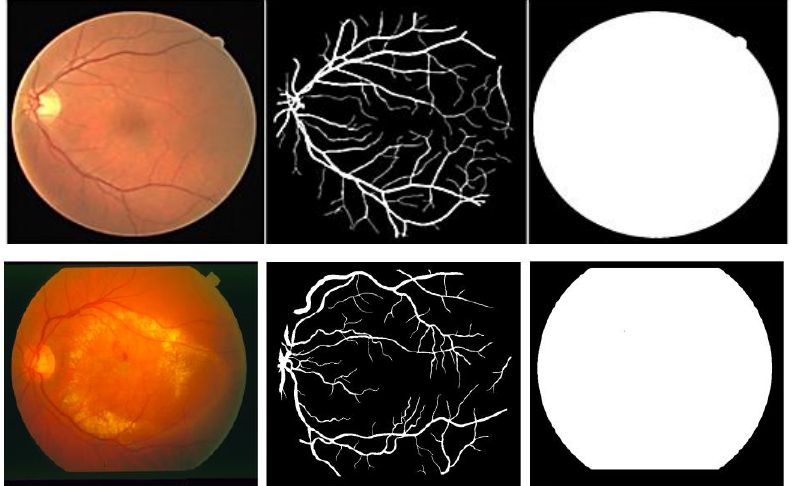
Figure 1. The original image ( right ), the corresponding ground-truth segmentation masks ( middle ), and the corresponding field-of-view masks ( left ). Example cases from the DRIVE ( top ) and from the STARE ( bottom ).